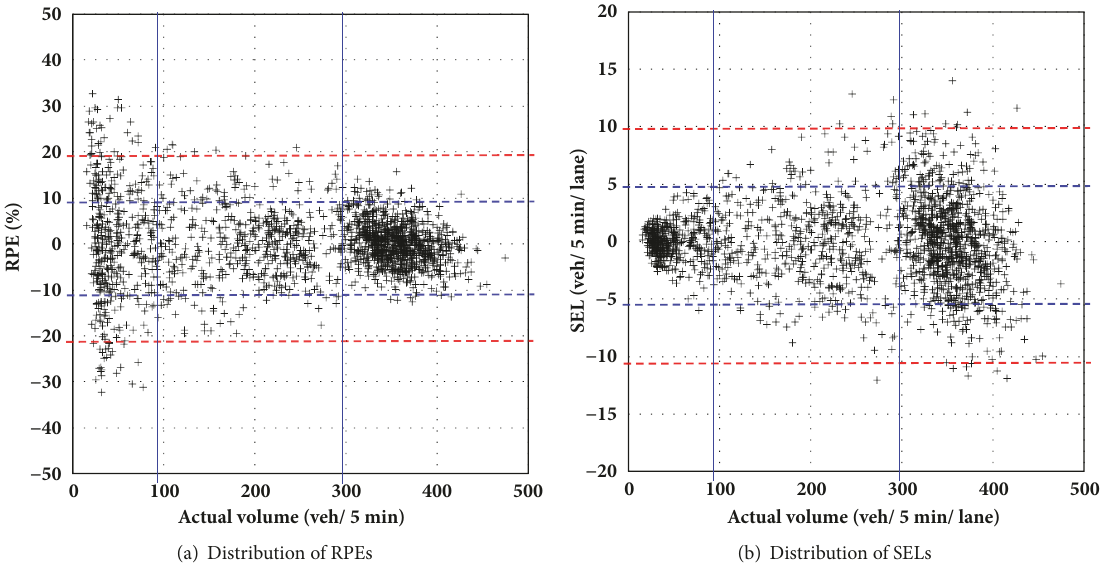
Figure 11: Distributions of estimation errors according to traffic